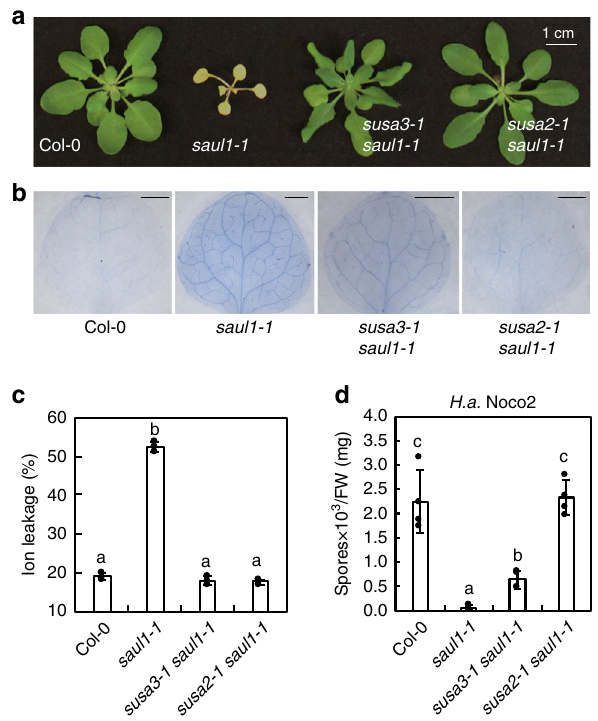
Fig. 1 Characterization of the susa2-1 saul1-1 and susa3-1 saul1-1 mutants. a Morphology of 3.5-week-old Col-0, saul1-1 , susa3-1 saul1-1, and susa2-1 saul1-1 plants. Plants were grown on 1/2 MS medium for 10 days and then transplanted to soil for another two weeks before the picture was taken. b Trypan blue staining of 14-day-old Col-0, saul1-1 , susa3-1 saul1-1, and susa2- 1 saul1-1 plants. Plants were grown on 1/2 MS medium for 7 days and then transplanted to the soil for another week to allow saul1-1 phenotype to develop. The scale bar shows 1 mm. c Ion leakage measurement of the indicated plants shown in a . Ion leakage was calculated as the percentage of the conductivity before autoclaving over that after autoclaving. Six leaf discs were used per genotype in 20ml H 2 O. Error bars represent means ± SD (one-way ANOVA, SPSS Statistics, n = 3, p < 0.01). Experiments were repeated three times with similar results. d Quanti fi cation of oomycete pathogen H.a . Noco2 growth on the indicated genotypes. Two-week-old plants were evenly sprayed with H.a . Noco2 conidiospores at a concentration of 100,000 spores/ml water. Quanti fi cation of conidia growth on leaf surface per mg FW was determined 7 days post-inoculation